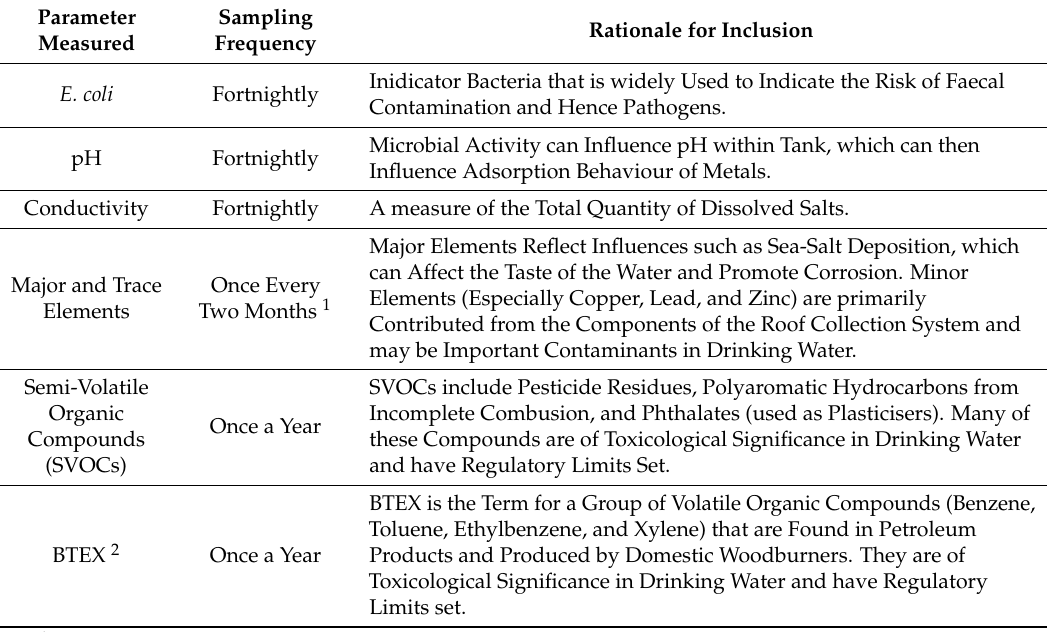
Table 2. Summary of water quality